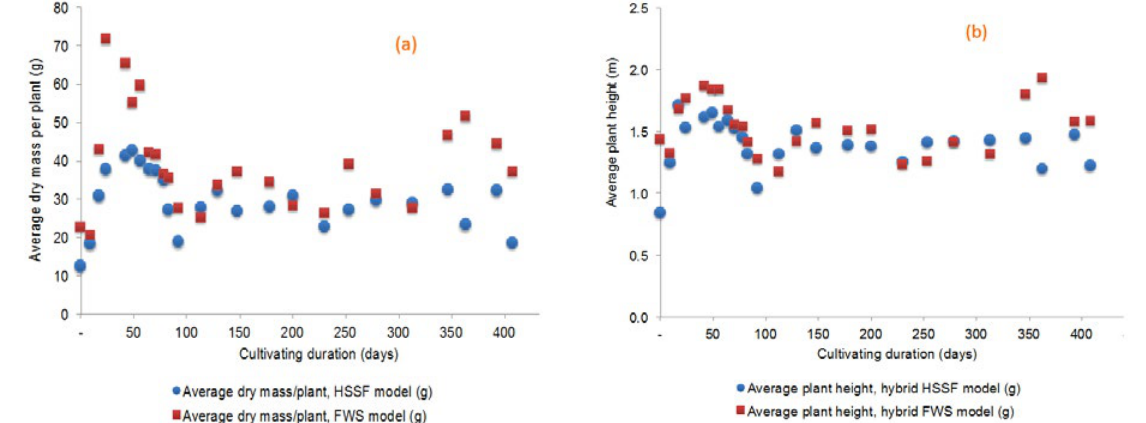
Fig. 4: Average dry biomass per plant (a) and average plant height (b) in the CWs